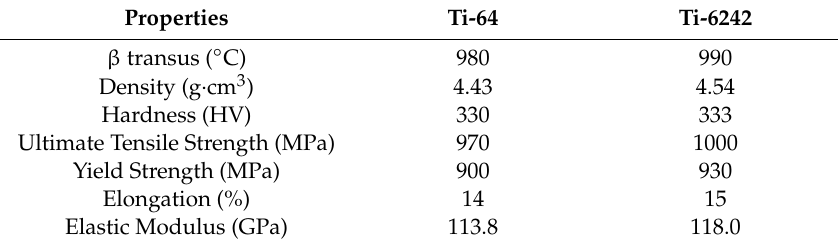
Figure 1. Schematic representation of length (L), width (W) and height (H) of the Ti-64 and Ti-6242 blocks with microstructures oriented in the rolling direction (RD) and transverse direction (TD), respectively. Table 2. Typical properties of Ti-64 and Ti-6242 PMs [40,41].